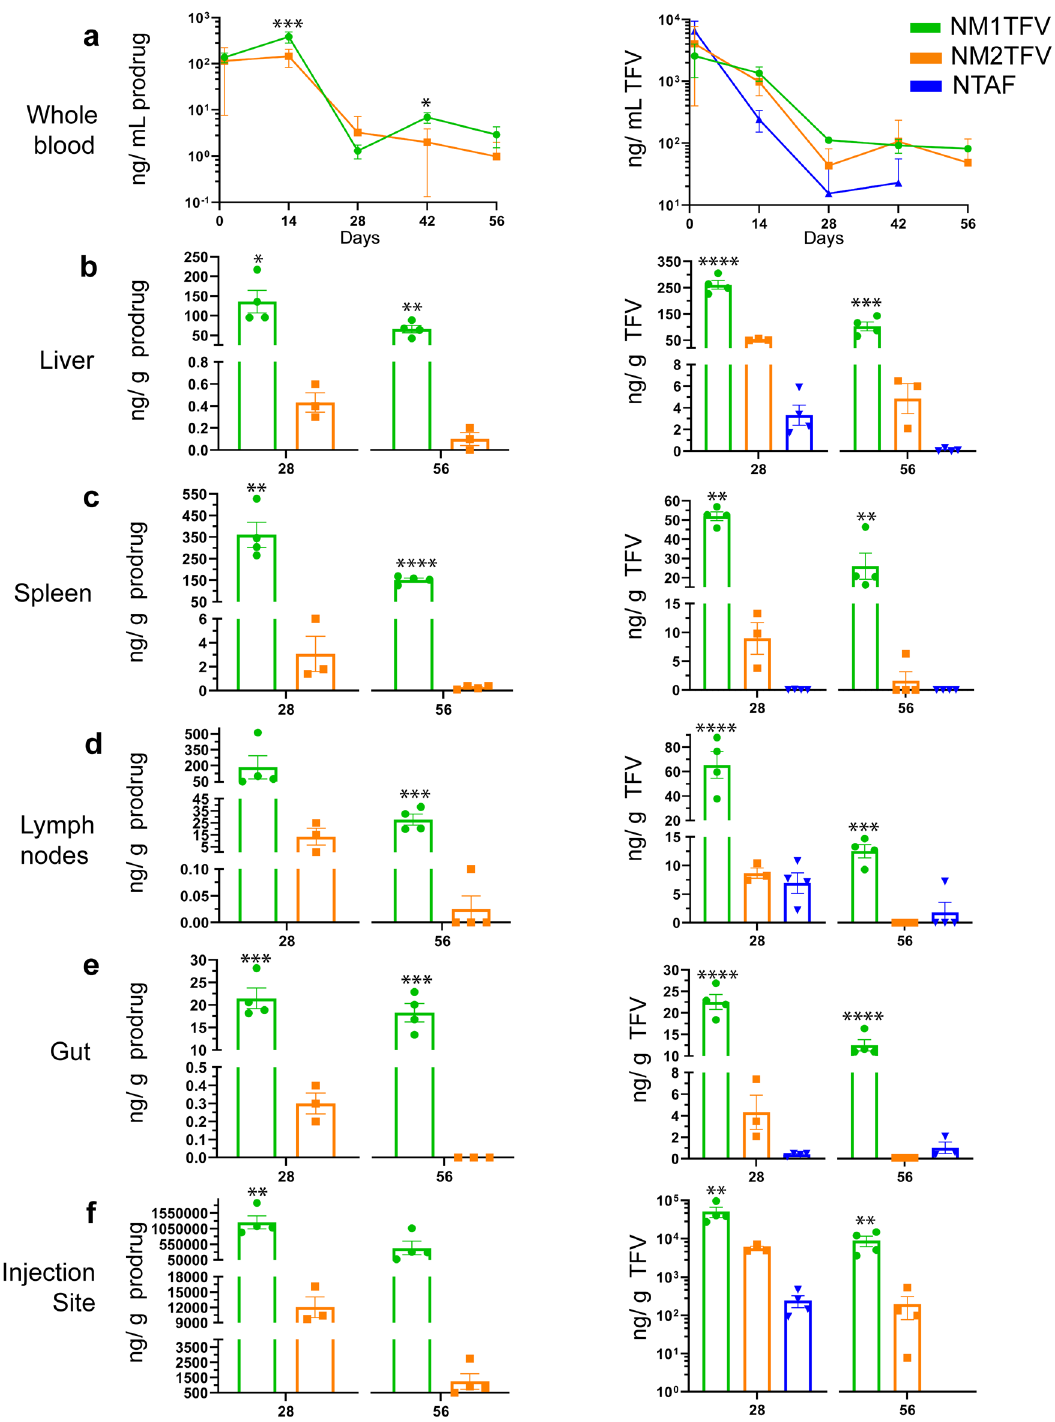
Fig. 5 Pharmacokinetics. SD rats were administered a single IM dose of NM1TFV (green), NM2TFV (orange), or NTAF (blue) (75 mg/kg TFV-eq.) to determine pharmacokinetic (PK) pro fi les. a Prodrug (left) and TFV (right) concentrations in blood were determined at days 1 and 14 then every two weeks for 8 weeks (*** P = 0.0001, * P = 0.0177 NM1TFV vs. NM2TFV prodrug). Tissue biodistribution of M1TFV, M2TFV, and TFV was assessed at 28 and 56 days after injection in the b liver (* P = 0.0107, ** P = 0.002 NM1TFV vs. NM2TFV prodrug; **** P < 0.0001, *** P = 0.0007 NM1TFV vs. NM2TFV TFV), c spleen (** P = 0.0034, **** P < 0.0001 NM1TFV vs. NM2TFV prodrug; ** P = 0.004, ** P = 0.0055, NM1TFV vs. NM2TFV TFV), d lymph node (*** P = 0.0009 NM1TFV vs. NM2TFV prodrug; *** P = 0.0001, **** P < 0.0001 NM1TFV vs. NM2TFV TFV), e gut (*** P = 0.0006, *** P = 0.0007 NM1TFV vs. NM2TFV prodrug; **** P < 0.0001 NM1TFV vs. NM2TFV TFV), and f site of injection (** P = 0.0043 NM1TFV vs. NM2TFV prodrug; ** P = 0.0084, using two-tailed unpaired t- test (**** P < .0001, *** P < .001, ** P < .01, * P < .05 NM1TFV compared with NM2TFV). To compare TFV levels between three or more groups, ordinary one-way ANOVA followed by Tukey ’ s post hoc test with a single pooled variance was used (**** P < .0001, *** P < .001, ** P < .01, * P < .05 NM1TFV compared with